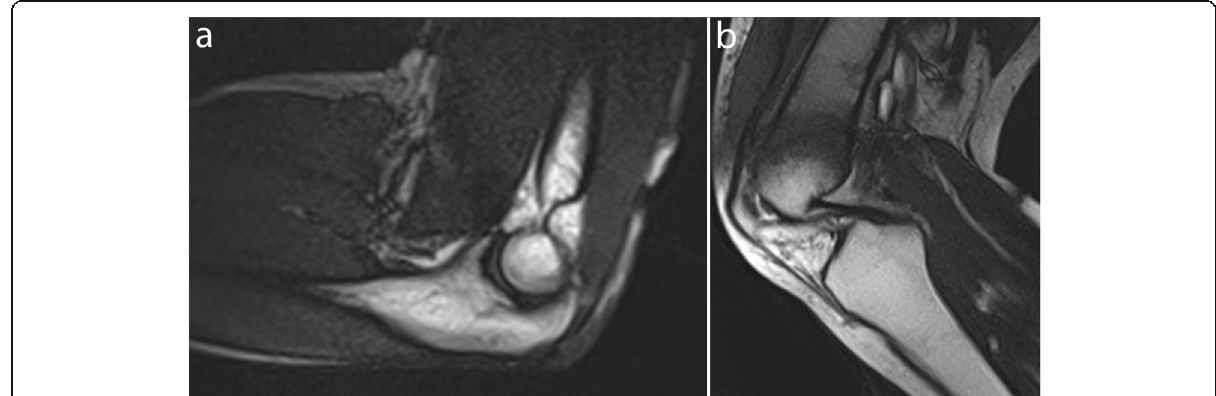
Fig. 2 Real-time dynamic MR images obtained with balanced SSFP sequence at 1.5 T. Elbow in the sagittal plane in flexion ( a ) and knee in the sagittal plane in flexion ( b ) (TR, 4.6; TE, 2.3; flip angle, 40°; pixel size, 1.09 × 1.46 mm)